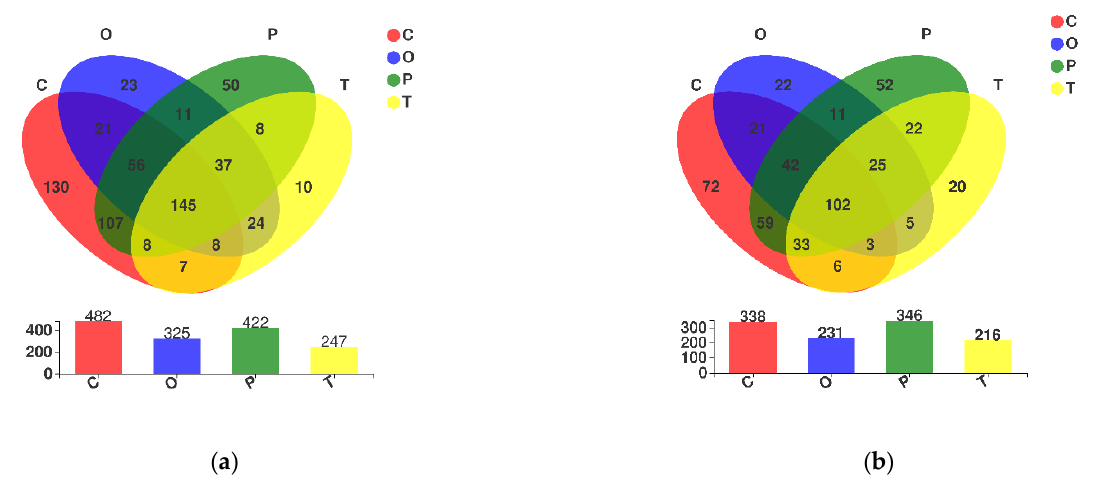
Figure 7. The enriched and depleted microorganism in moss-dominated biocrusts soils. Area-proportional Euler diagrams were built to depict the exclusive and the shared genera. Number of ( a ) bacterial genera and ( b ) fungal genera shared among Claopodium rugulosifolium , Orthotrichum courtoisii , Polytrichum formosum , and Taxiphyllum giraldii is depicted within the intersection while the number of genera exclusive to each moss type can be seen out of the intersection zone. The genera exclusive to the Claopodium rugulosifolium soil are visible in the red colored area. C: Claopodium rugulosifolium ; O: Or-